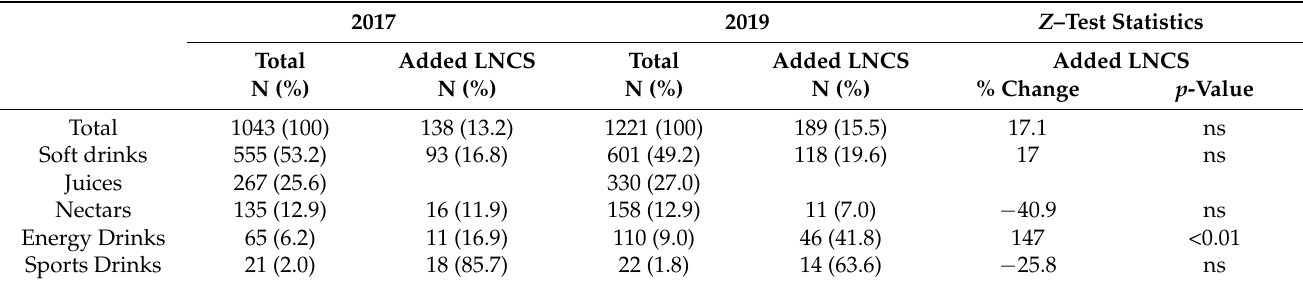
Table 1. Sample description and the use of low and no-calorie sweeteners (LNCS) in non-alcoholic beverages in 2017 versus 2019 (N—number of all products; % diff.—% difference;